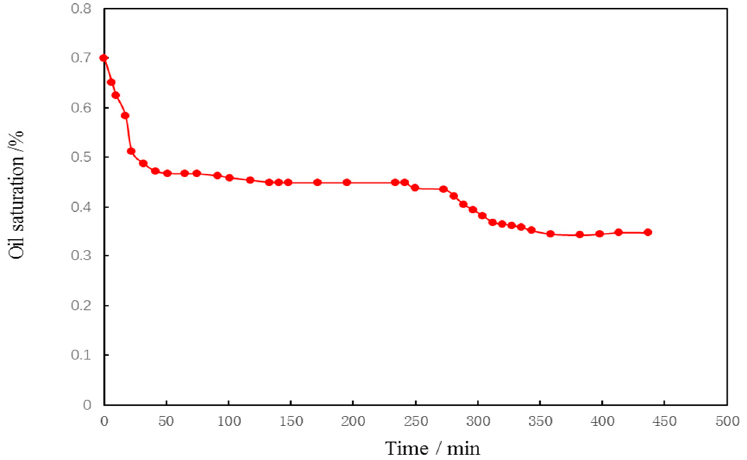
Figure 9. Chart oil saturation versus